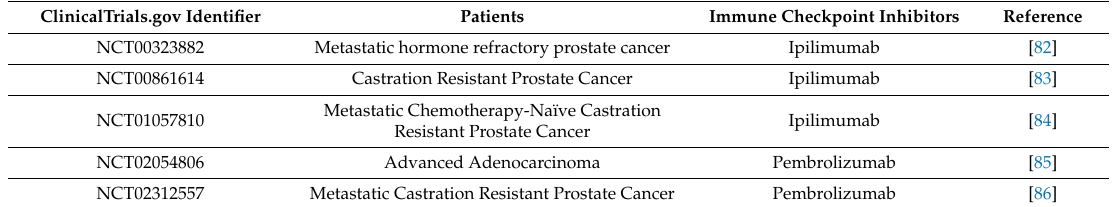
Table 3. Clinical trials on the use of immune checkpoint inhibitors in prostate cancer. ClinicalTrials.gov